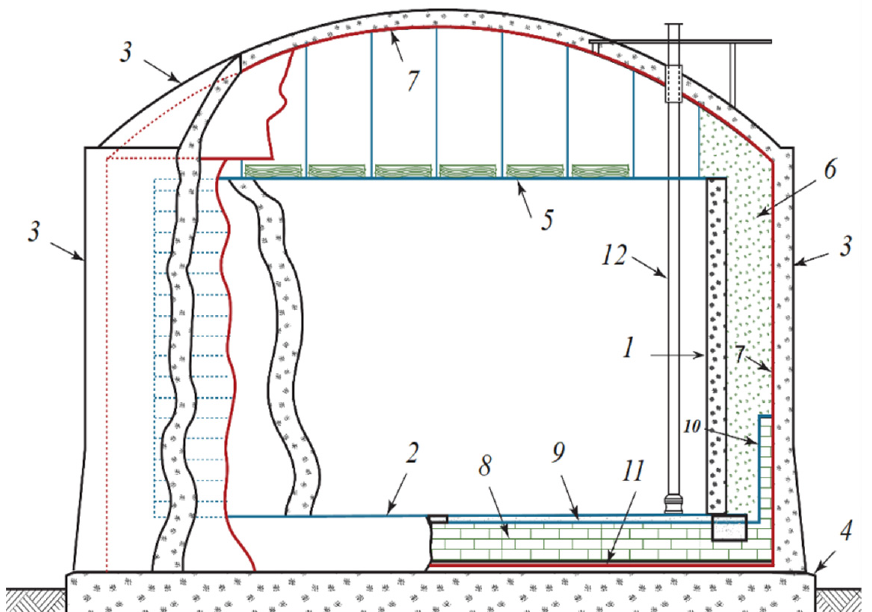
Figure 5. Schematic of a complete-constraint double-wall cryogenic tank, where the liquid, vapor receptacle, and roof are of concrete material; 1—Main liquid vessel, 2—Tank bottom, 3—Secondary vessel, 4—Foundation, 5—Balanced surface, 6—Annular area insulation, 7—Vapor container, 8—Floor insulation, 9—Secondary liquid vessel, 10—Thermal safety, 11—Moisture vapor barrier, 12—Pump column [38].